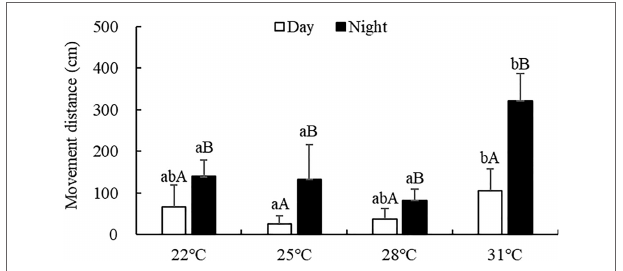
FIGURE 2 | Movement distance of S. monotuberculatus at four temperature conditions. Marks of lowercase letters indicate that there is a significant difference at different temperatures ( P < 0.05); marks of uppercase letters indicate that there is a significant difference between day and night ( P < 0.05).